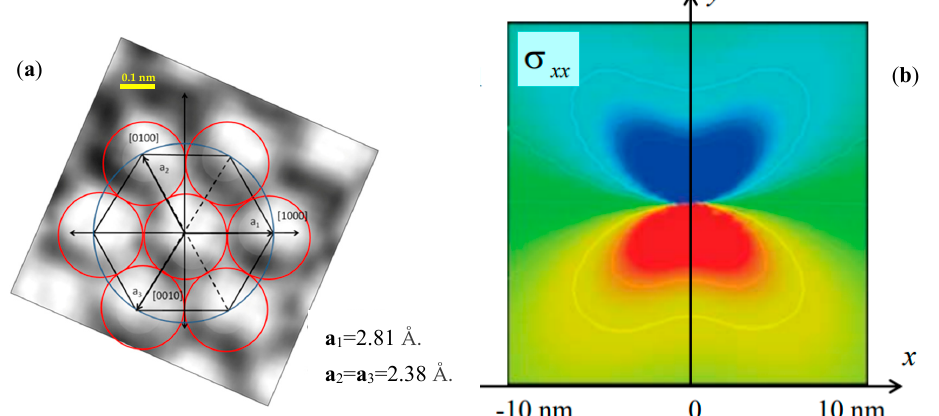
Figure 14. ( a ) Representative hexagon at the dislocation edge; ( b ) typical stress distribution σ xx for a Volterra’s type dislocation [37]. The peak tensile stress (red) is 5 GPa; the peak compressive stress (blue) is − 5 GPa.